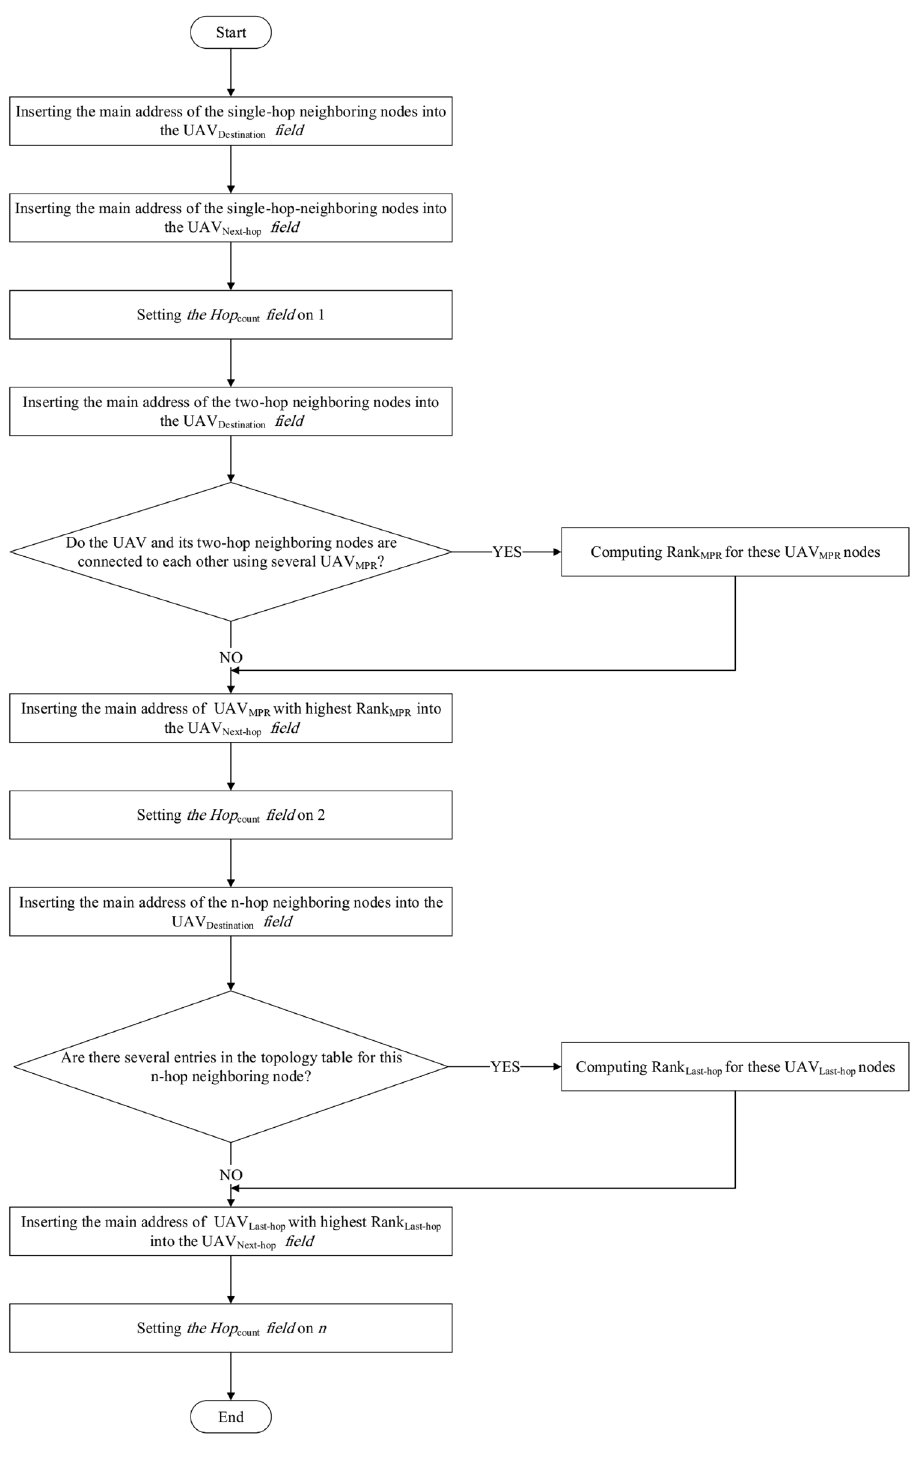
Figure 7. Flowchart of calculating routing